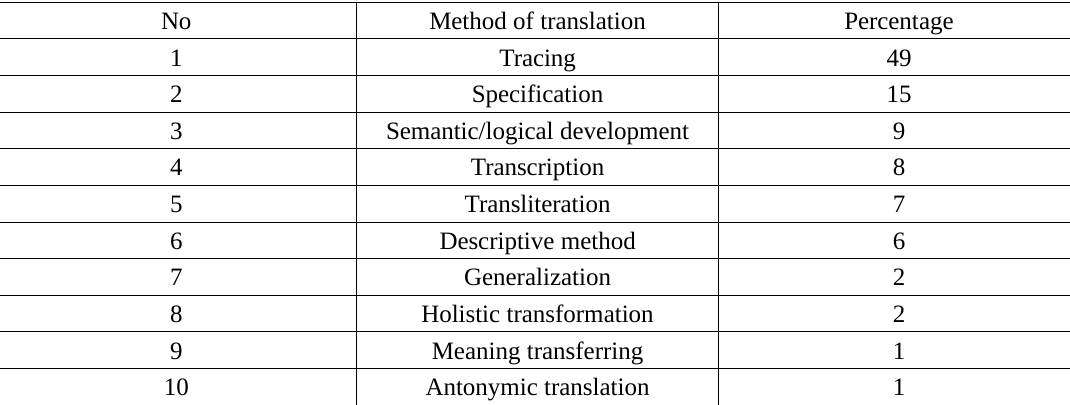
Table 1 - Methods of